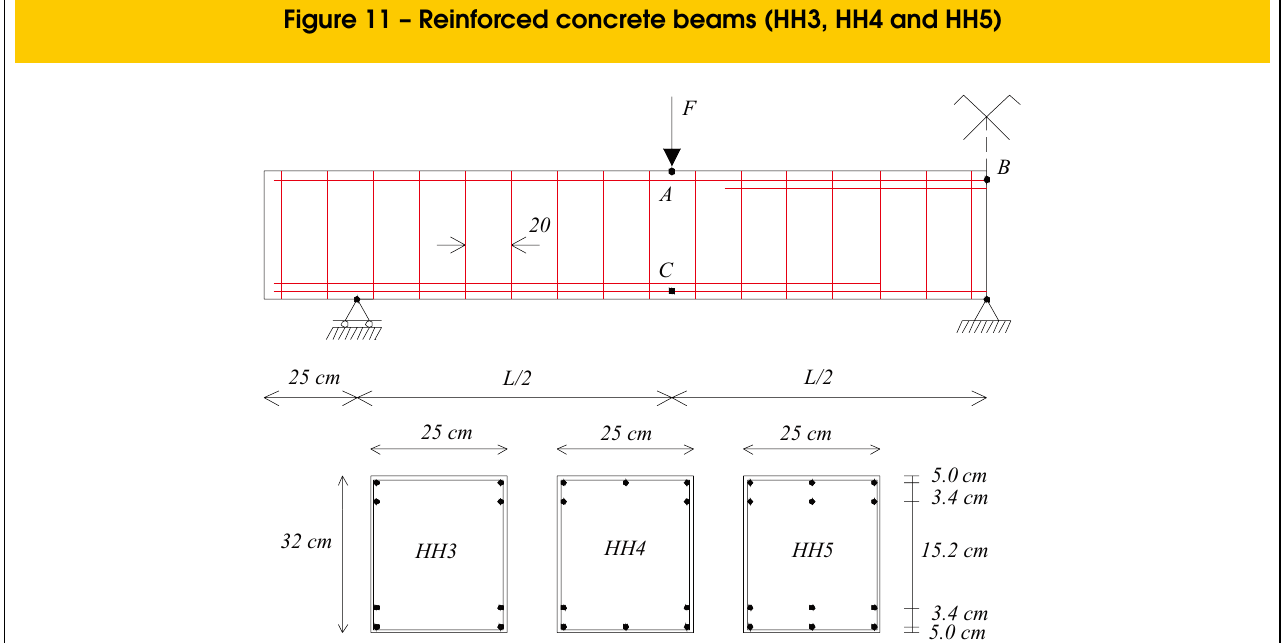
Figure 11 – Reinforced concrete beams (HH3, HH4 and